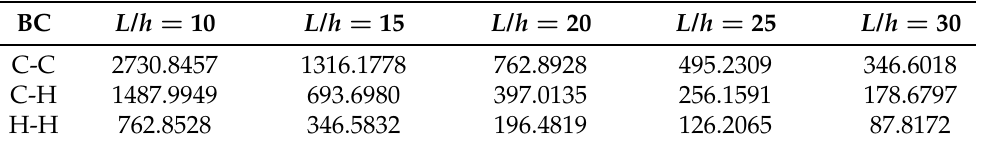
Table 5. Effect of boundary conditions and slenderness ratio L / h on critical buckling temperature